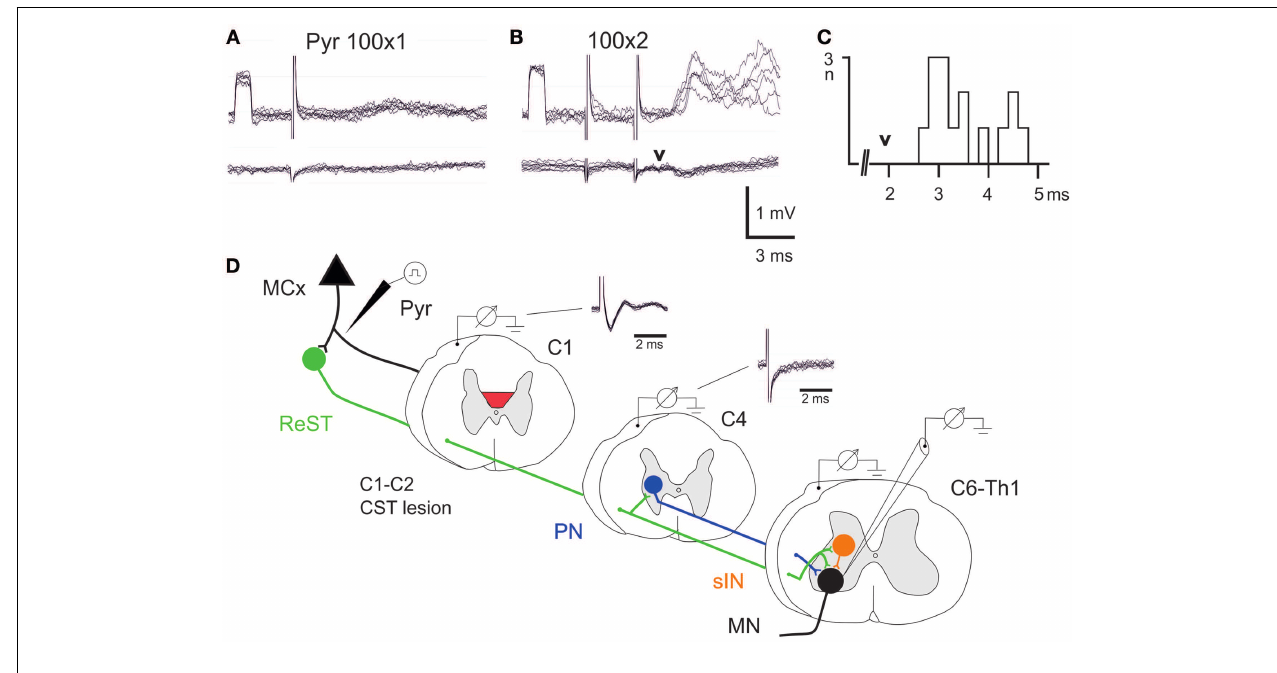
indicates the arrival of the synaptic volley in C7. (D) Schematic circuit diagram of demonstrated cortico-motoneuronal pathways. ReST in green, PN pathway in blue and sINs in orange. Note that the ReST has both monosynaptic projection to MNs and disynaptic projection via PNs and sINs.The red area indicates the lesion of CST in C1–C2. Cord dorsum recordings from C1 and C4 evoked by a single stimulation in the contralateral pyramid at 100 µ